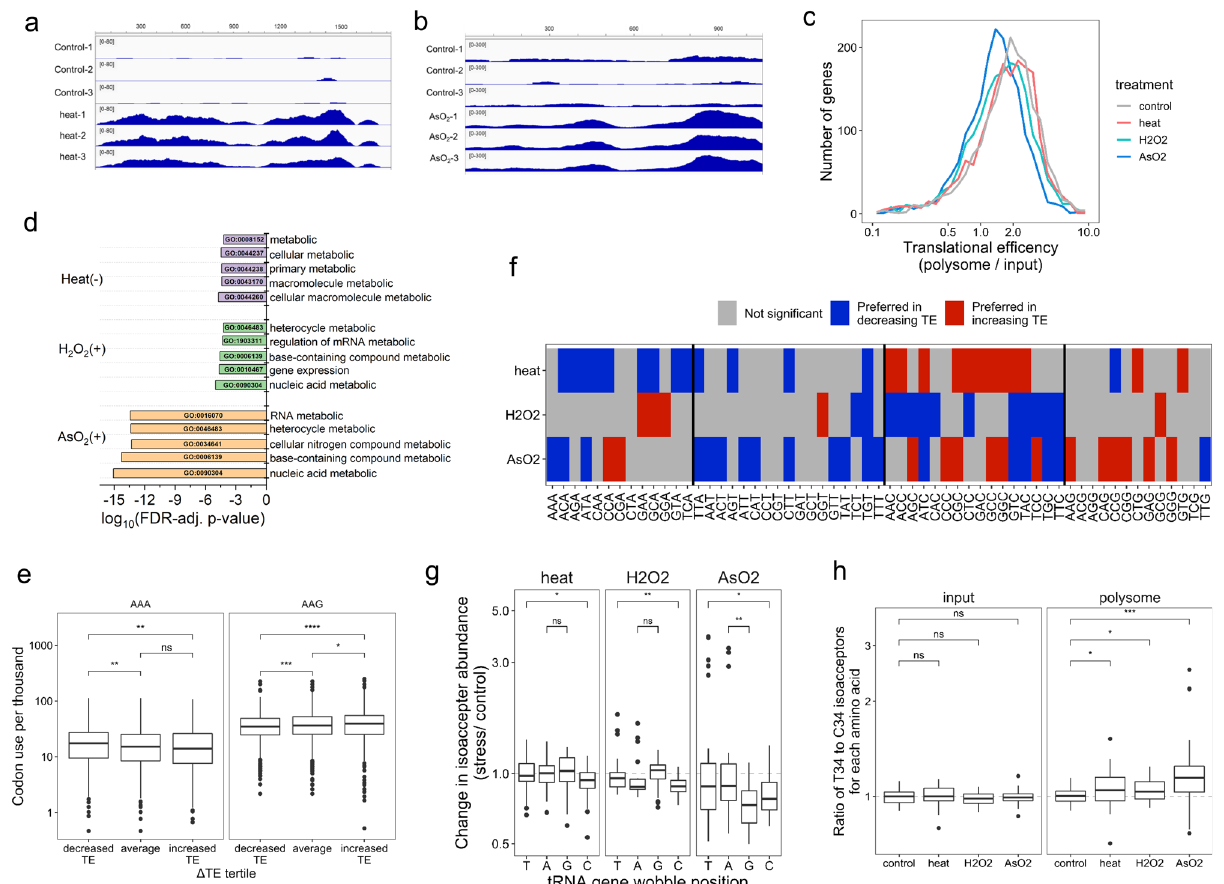
Fig. 5 mRNA analysis of total RNA and on polysome under stress. mRNA-seq was performed in biological triplicates ( n = 3) for each condition. Box and Whisker plots show median, 25th and 75th quartile, and whiskers to 1.5 times interquartile range. a IGV plot for the coding region of the HSP1A1 mRNA transcript, unstressed control (top), and heat stress (bottom) shows stress-increased read coverage along the length of the CDS. b IGV plot for the coding region of the ATF4 mRNA, unstressed control (top), and arsenite stress (bottom) showing stress-increased read coverage along the length of the CDS. c Histogram of translation ef fi ciency (TE) among commonly detected mRNA genes in all conditions, in 30-gene increments. d Gene ontology analysis of biological processes among genes with stress-induced changes to TE. ( + ) Genes with highly increased translation ef fi ciency, ( − ) Genes with highly decreased translation ef fi ciency. e Lysine codon usage for AAA and AAG is compared between genes in the bottom, middle, and top tertile of Δ TE values during arsenite stress. **** p < 10 − 4 , *** p < 10 − 3 , ** p < 0.01, * p < 0.05, ns not signi fi cant; signi fi cance calculated with two-sided Wilcoxon test. Data were shown for n = 3 independent biological replicates for n = 1747 genes, comparing tertiles. P values (top to bottom) for AAA are 2.6 × 10 − 3 and 9.5 × 10 − 3 , and for AAG 1.7 × 10 − 8 , 4.3 × 10 − 2 , and 3.5 × 10 − 4 . f Heat map showing signi fi cant differences in codon use between genes with increasing versus decreasing TE during stress. Signi fi cance is computed as Wilcox test p < 0.05 for comparing codon use between genes in the top and bottom tertile of Δ TE values for each stress. The heat map shows codons preferred by genes with increasing TE (red) or decreasing TE (blue) ( g ) tRNA abundance change on the polysome for isoacceptors with different wobble anticodon nucleotide in the tRNA gene. ** p < 0.01, * p < 0.05, ns not signi fi cant; signi fi cance calculated with two-sided Wilcoxon test. Data were shown for n = 3 independent biological replicates for 42, 24, 24, and 48 isodecoders with wobble nucleotide T, A, G, or C, respectively. P values (top to bottom) for heat: 1.3 × 10 − 2 H 2 O 2 : 2.3 × 10 − 3 NaAsO 2 : 1.5 × 10 − 2 , 5.9 × 10 − 3 . h tRNA abundance change of the ratios for T34 versus C34 wobble anticodon tRNA for each amino acid, total RNA input on the left, and on the polysome on the right. *** p < 10 − 3 , * p < 0.05, ns not signi fi cant; signi fi cance calculated with two-sided Wilcoxon test. Data were shown for n = 3 independent biological replicates for 11 amino acids. P values (top to bottom) for polysome are 7.4 × 10 − 4 , 2.4 × 10 − 2 , 3.7 × 10 − 2